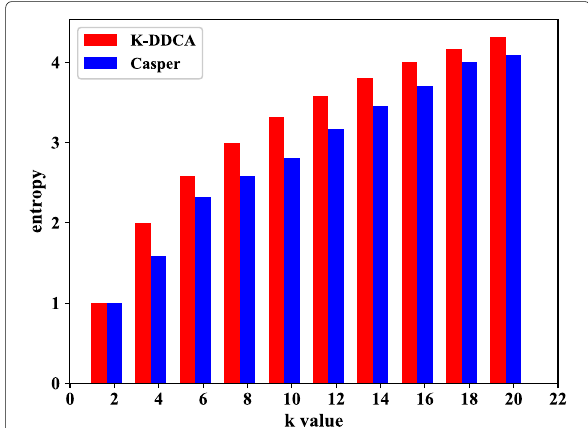
Fig. 9 Comparison of anonymity between the K-DDCA algorithm and the Casper algorithm under different k values. It indicates the privacy level in terms of entropy of different schemes, and the anonymity of the K-DDCA algorithm and Casper algorithm gradually increases with the raise of the k value